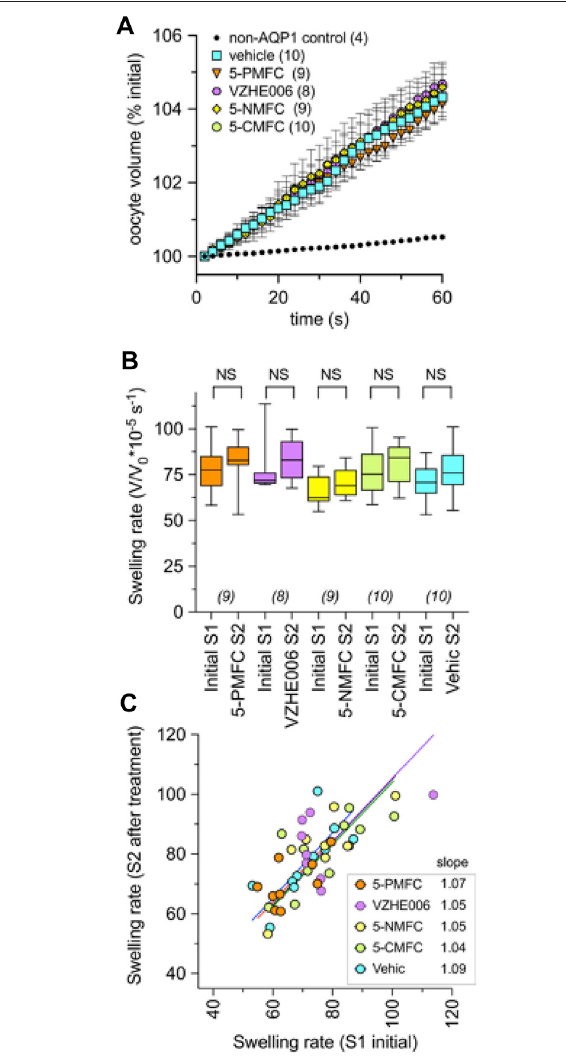
FIGURE 5 | Osmotic water permeability of AQP1-expressing oocytes is not altered by treatment with the furan derivatives. (A) Mean swelling responses of AQP1 expressing oocytes in 50% hypotonic saline were not affected after 2 h of preincubation in the furan derivatives (2 mM). Data aremean ± SEM; n valuesareasshowninthekey. (B) Compiledboxplotdata showingcomparable swelling rates measured in thesame oocytes forthe fi rst (S1) assay before and second (S2) assay after 2-h incubation in saline with indicated treatments. Statistical signi fi cance was assessed by ANOVA and post hoc paired Student T tests; NS not signi fi cant. (C) The plot of S1 vs. S2 swelling rates for individual oocytes shows a linear relationship (slope values near 1.0) in all treatment conditions, indicating no effect on water channel activity, and no change in oocyte membrane integrity or levels of AQP1 channel expression during pharmacological incubation or repeated assays. “ Vehic ” is vehicle control (equivalent DMSO).